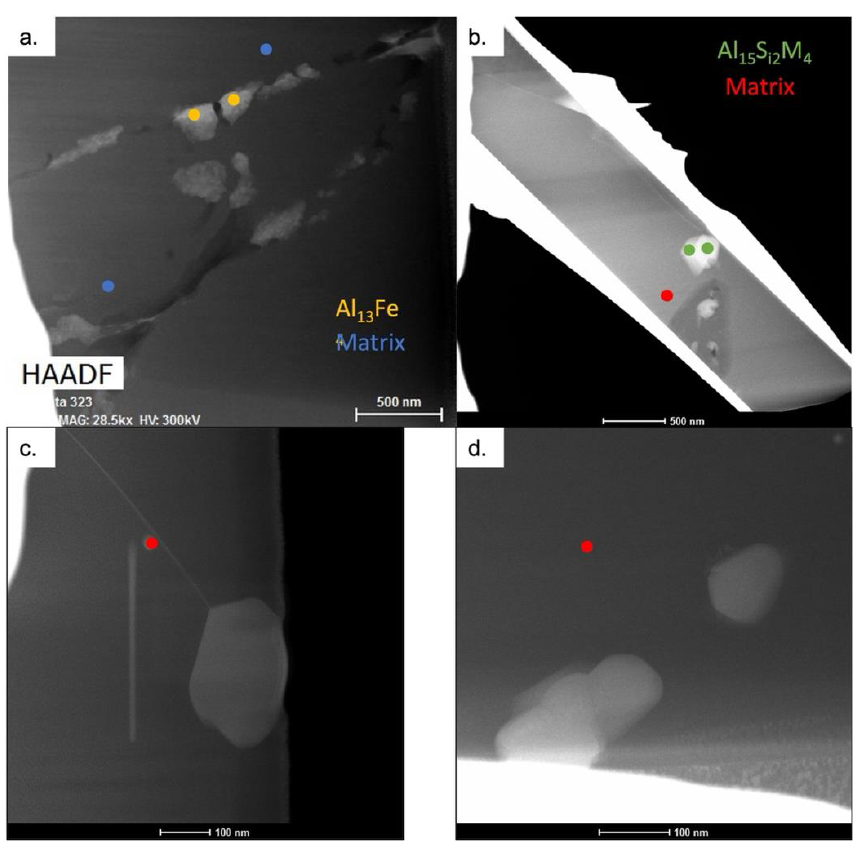
Figure 9. TEM micrographs depicting the locations of measurements taken for calculation of phase compositions in Table 3 for the ( a ) as-atomized, and ( b – d ) thermally treated at 530 °C microstructures. Table 4. Secondary phase stoichiometry from Thermo-Calc database.